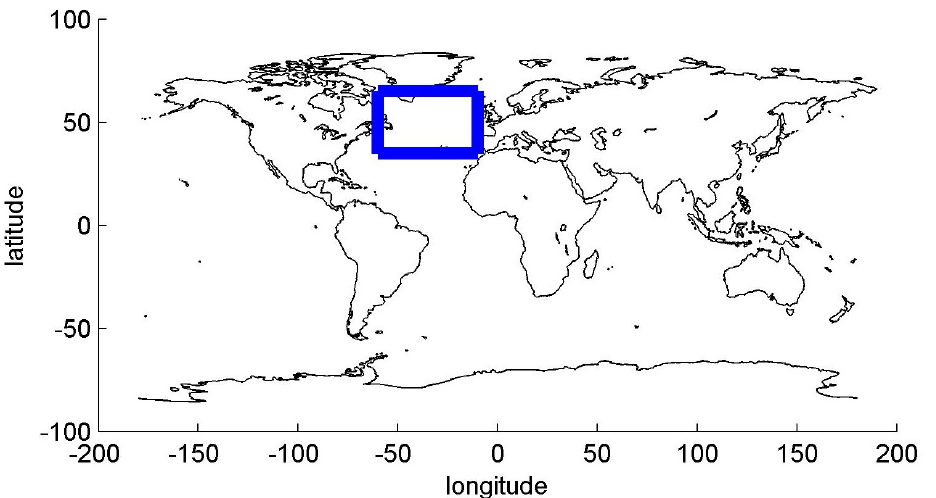
Figure 3. Blue rectangle shows the sector we used for the NCEP data.